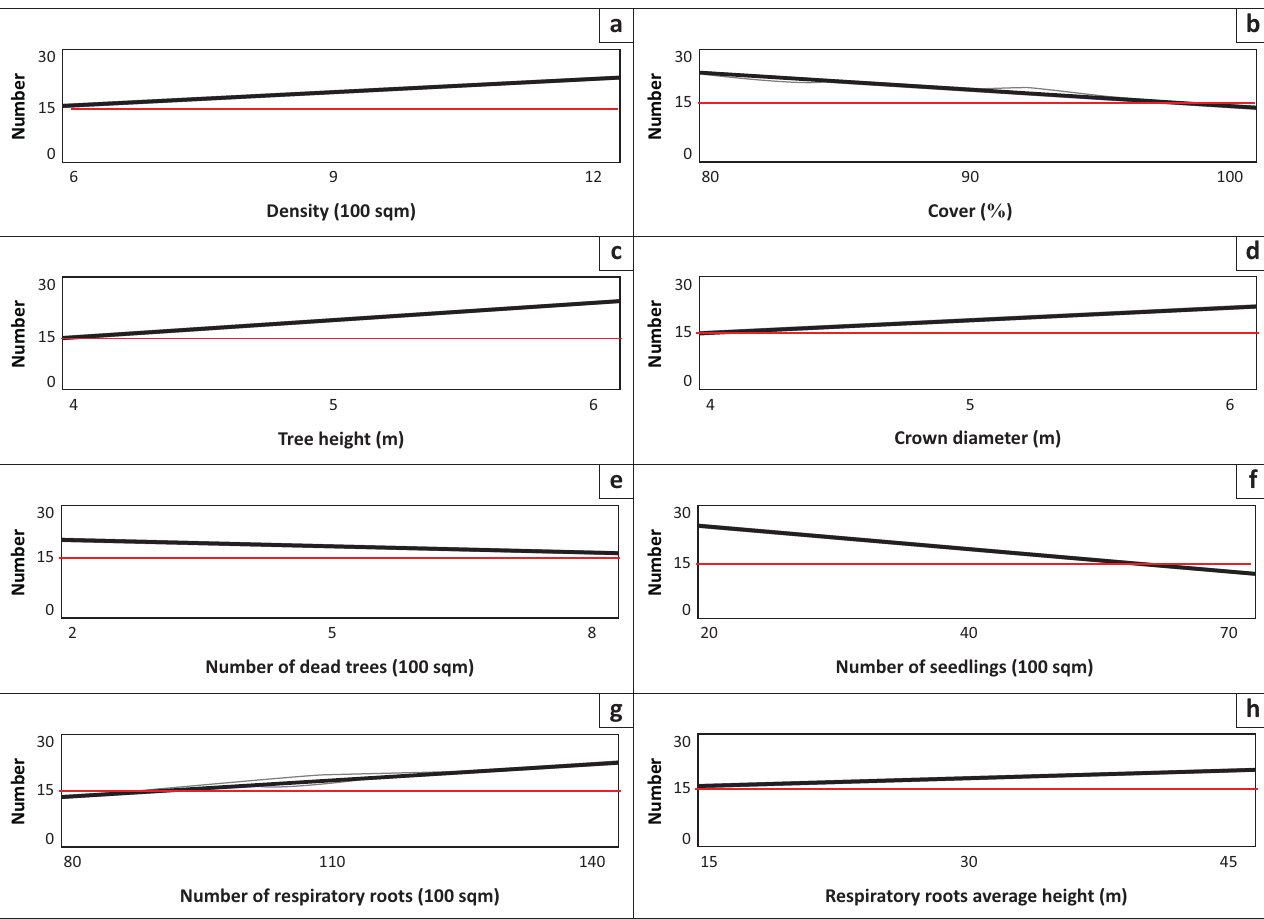
FIGURE 7: Safwa Al Khurais demographic features sensitivity analysis: (a) Density (100 m 2 ); (b) Cover ( % ); (c) Tree height (m); (d) Crown diameter (m); (e) Number of dead trees (100 m 2 ); (f) Number of seedlings (100 m 2 ); (g) Number of respiratory roots (100 m 2 ) and (h) Average height of respiratory roots (m).